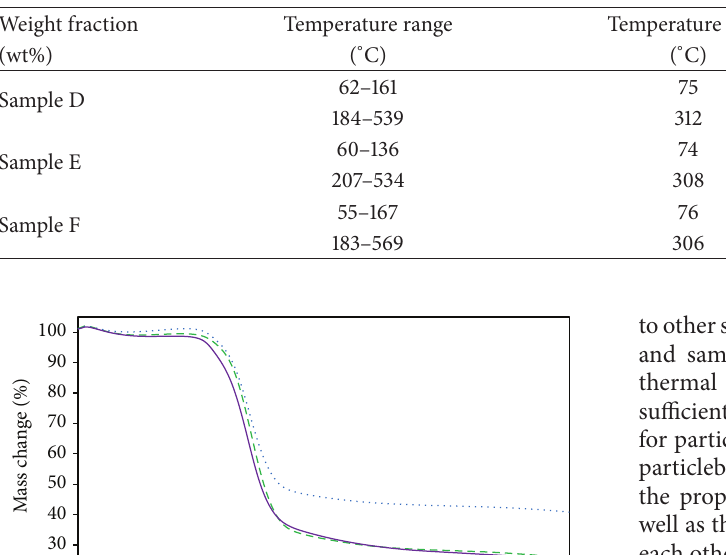
Table 2: Results for Sago/UF Sample with different weight fraction analysis by TGA.